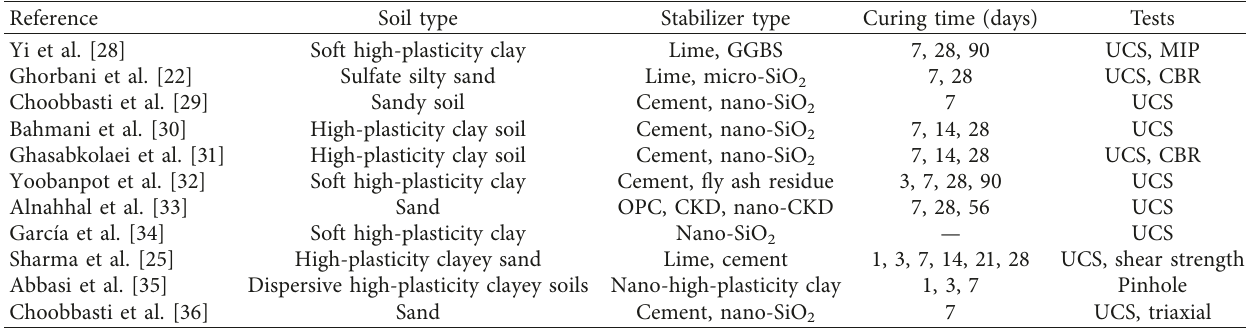
Table 1: Examples of recent soil stabilization research.